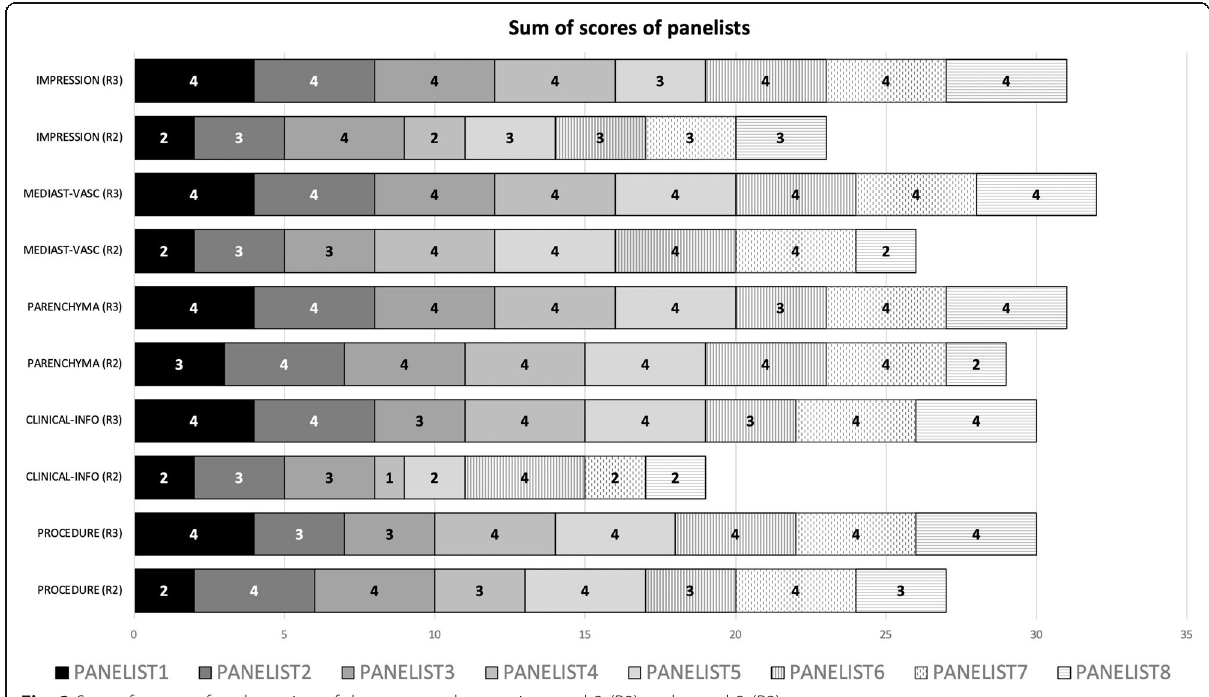
Mean scores and std.dev. and sum of scores by each section of the structured report Mean (std.dev.)